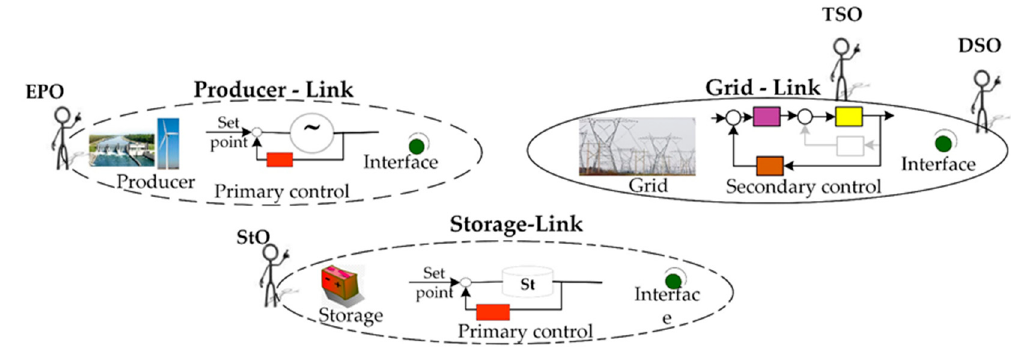
Figure 14. Main elements of the LINK -based holistic architecture and the corresponding operators.